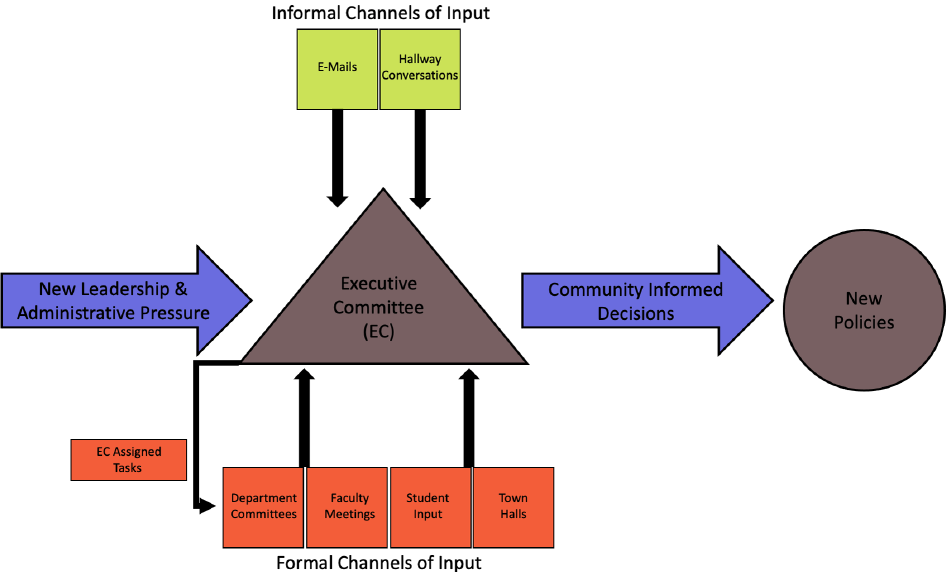
FIG. 4. Flow diagram of the change process.